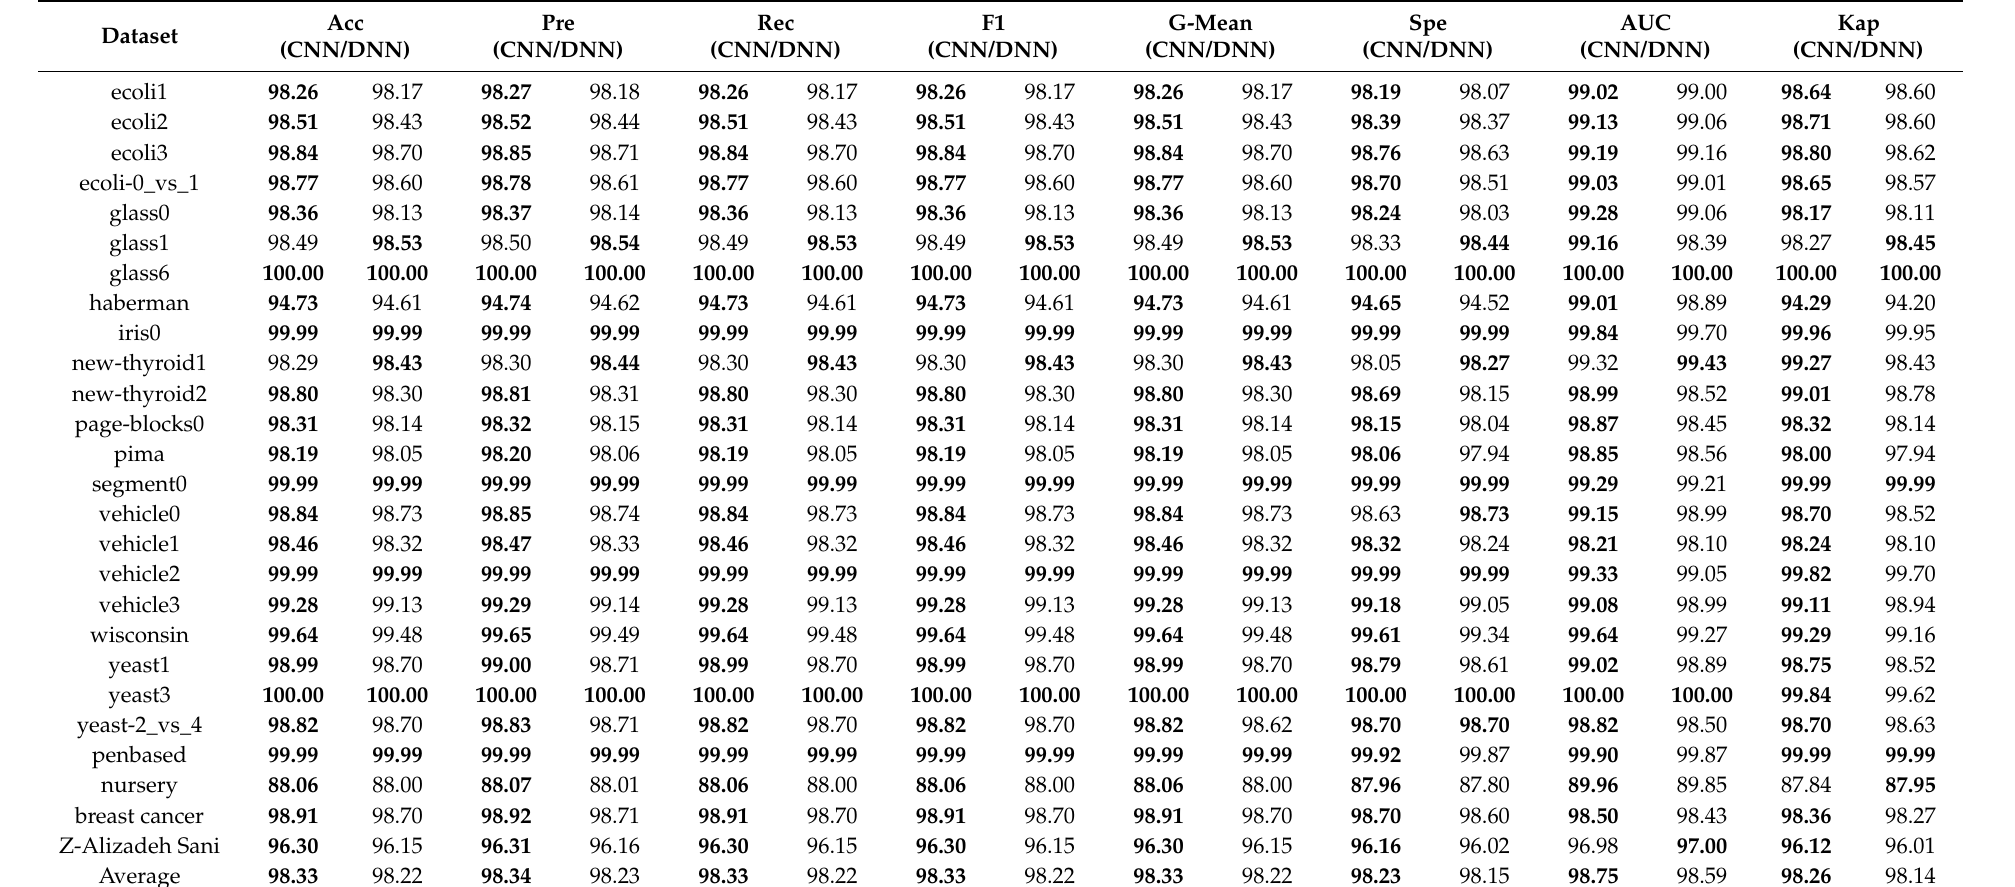
Table 11. RUS + NORM. +